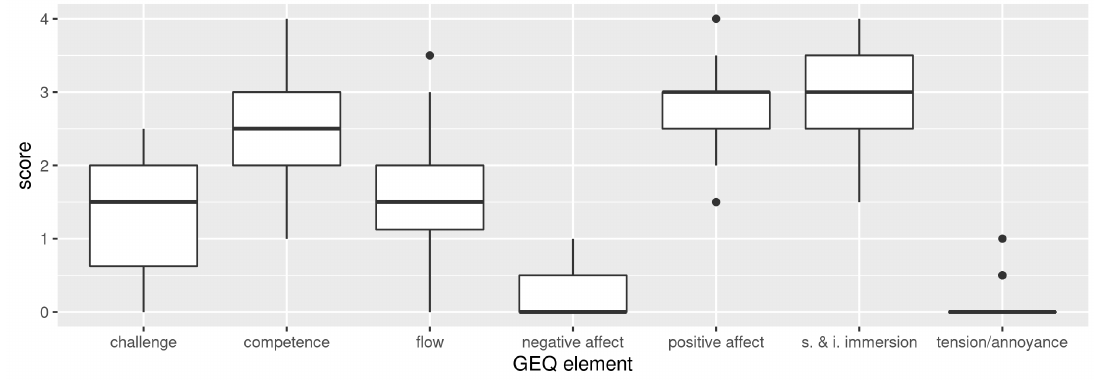
Figure 15. Box plot of average Game Experience Questionnaire (GEQ) in-game